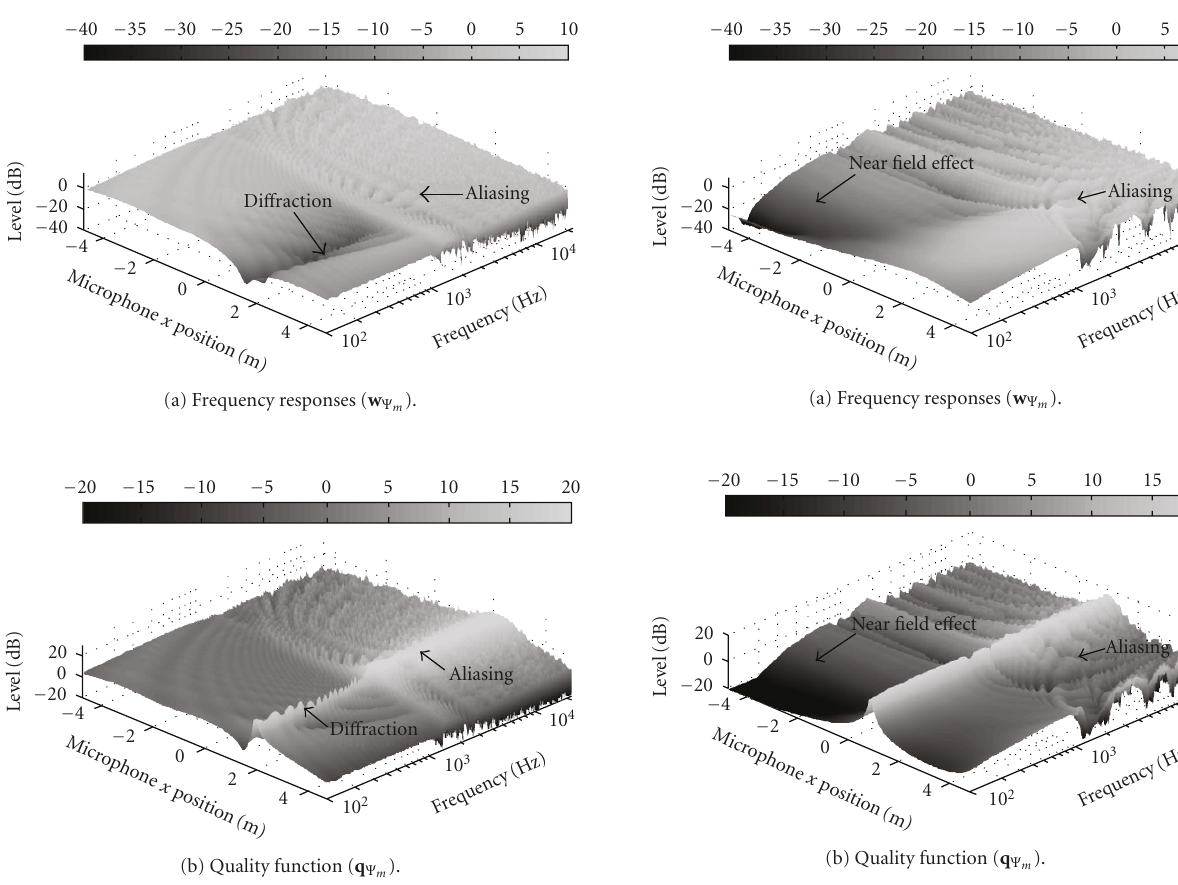
) and quality function ( q Ψ ) m m